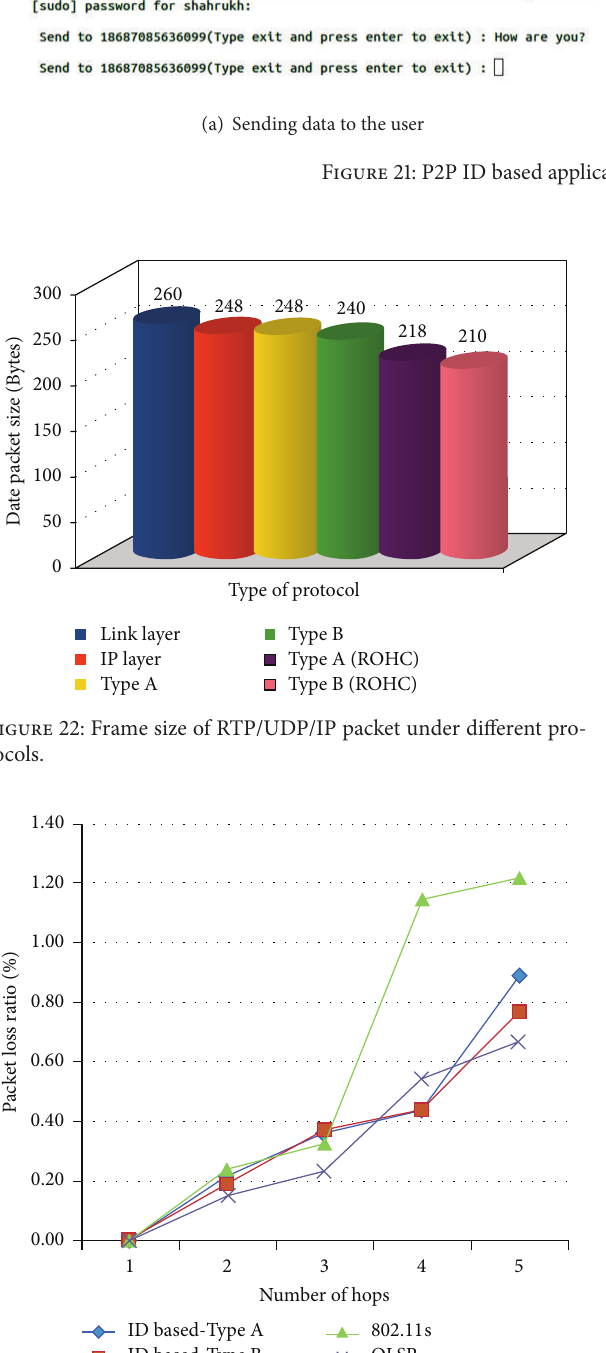
Figure 25: Total transmitted bytes under different scenarios. Table 5. In IP based architecture the nodes use IP